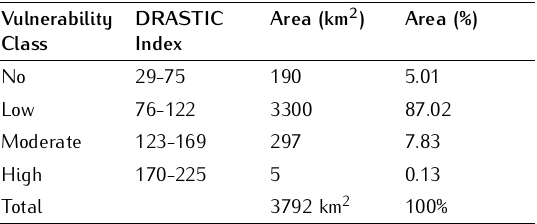
Table 7. Modified DRASTIC index categories using lineament density and areas vulnerable to groundwater pollution.